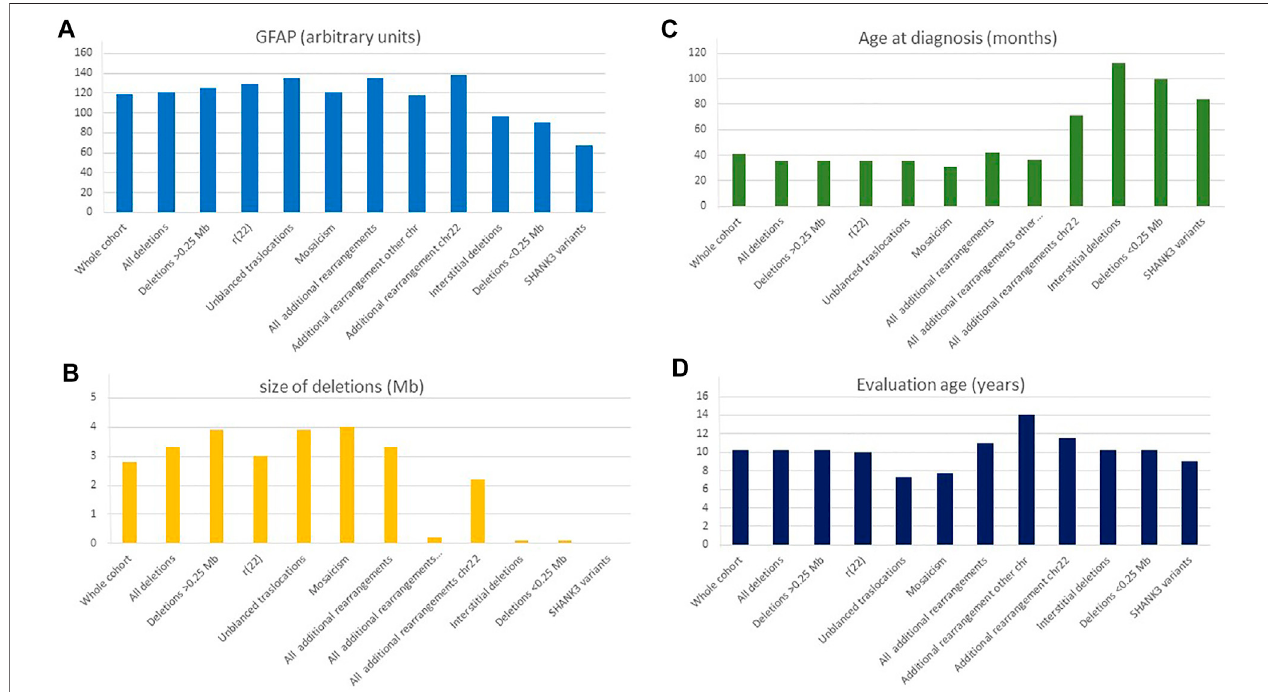
FIGURE 6 | Distribution of continuous variables according to the type of genetic defect. (A) GFAP, global function assessment of the patient (arbitrary values); (B) Size of the deletions (Mb); (C) Age at diagnosis (months); (D) Age at evaluation (years). *ASD diagnosis according to the psychiatrists of the referring institutions.